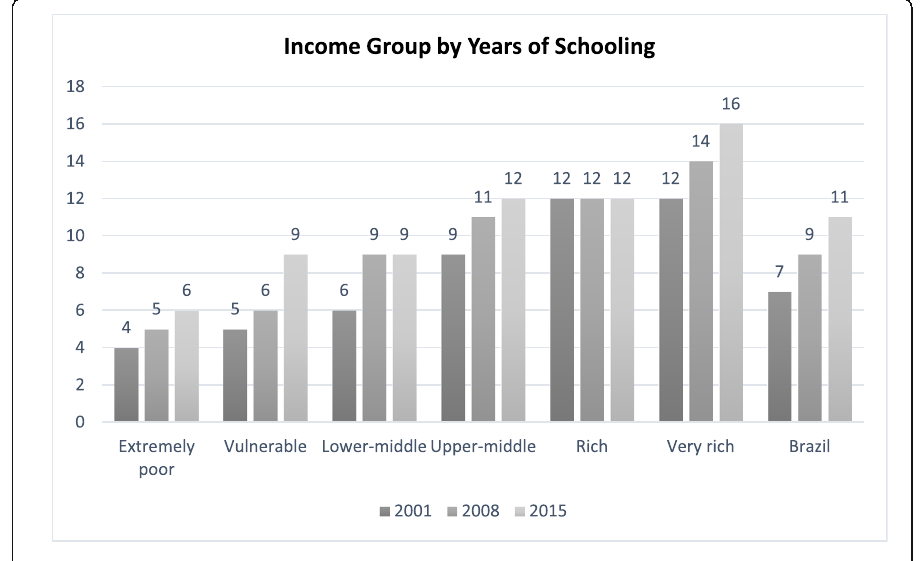
Fig. 2 Income group by years of schooling. Data source: National Household Sample Survey, 2001, 2008, and 2015 —